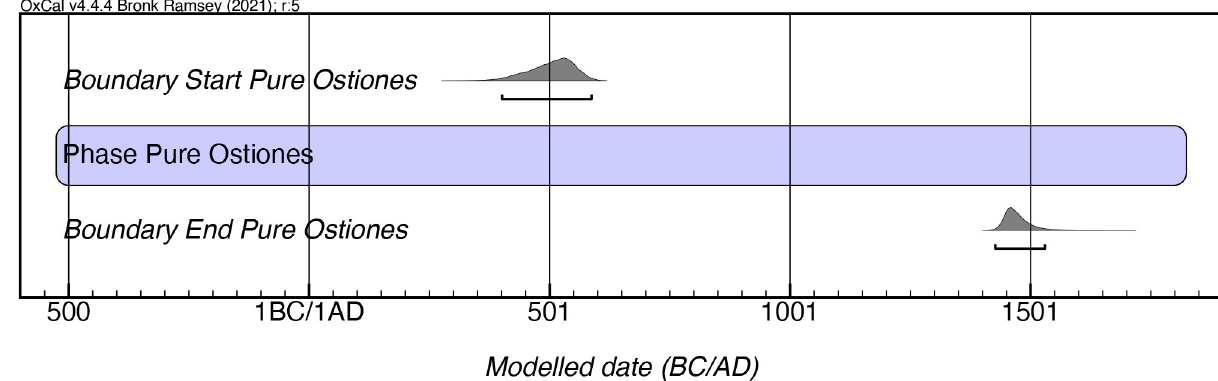
Fig 11. Modeled date ranges for the Pure Ostiones manifestation in Puerto Rico. Probability distributions indicate modeled 2 σ (95.4%) confidence intervals for beginning and end of phase.